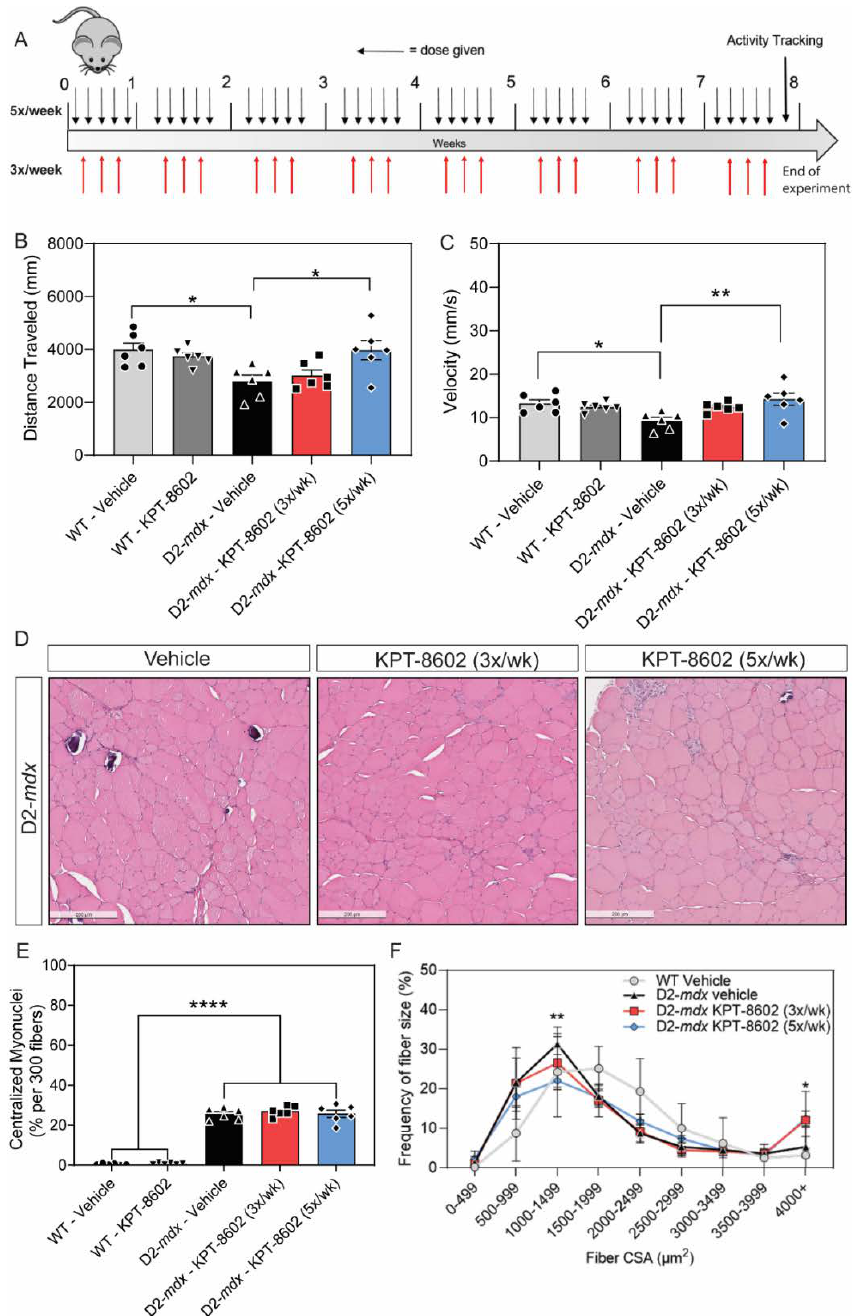
Figure 2. KPT − 8602 treatment improves basal locomotion and histological markers in DMD mouse muscle. ( A ) Schematic of mouse experiments illustrating the timeline of dosage in each condition